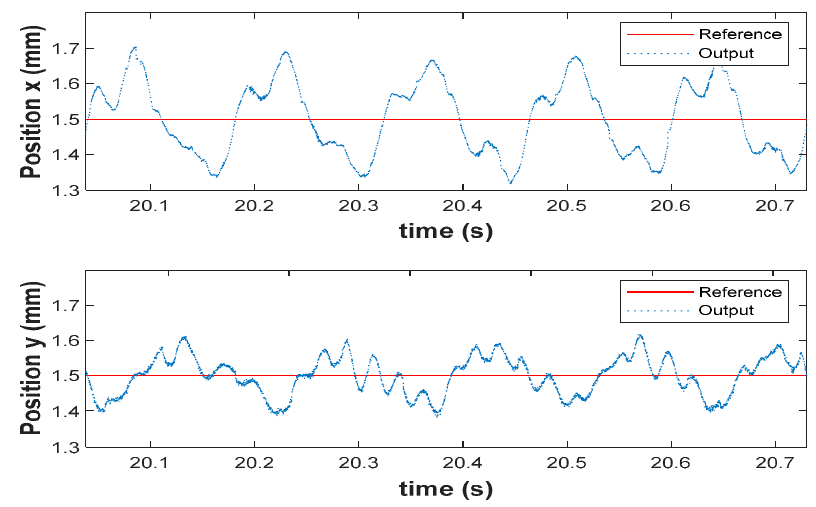
Figure 16. The response of AMB at 500 rpm in both x and y planes.